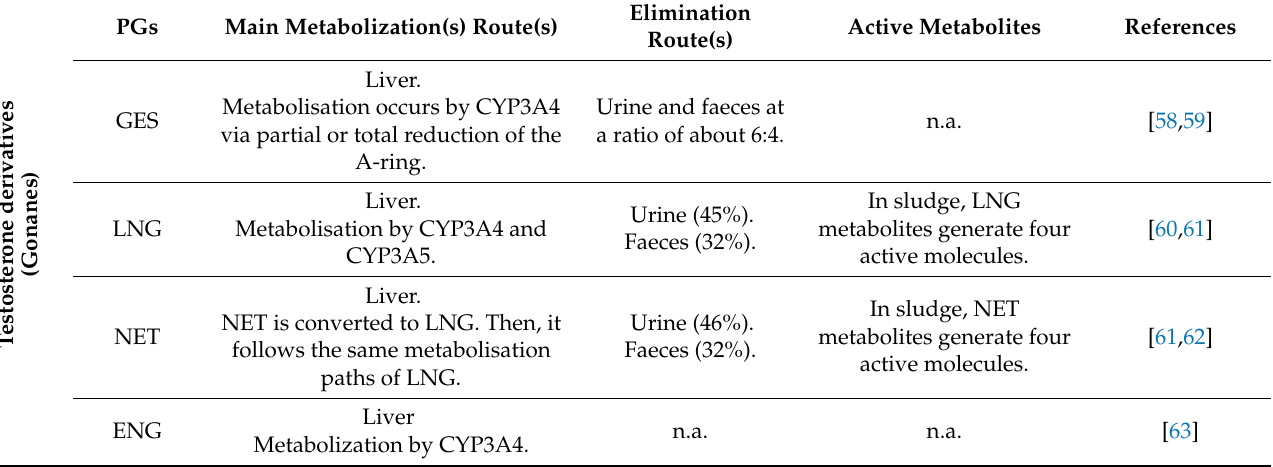
Table 4. Main metabolisation organ and enzymes, elimination routes, and the number of active metabolites for the PGs referred to in this study. Data not available